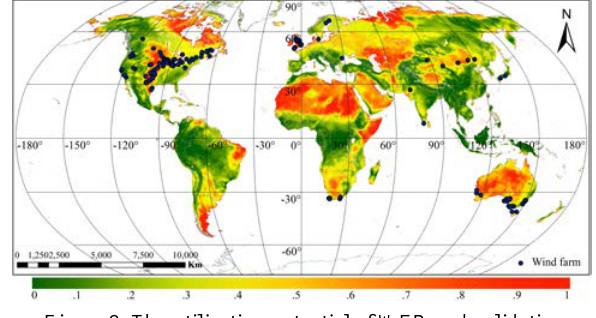
potential are relatively low.